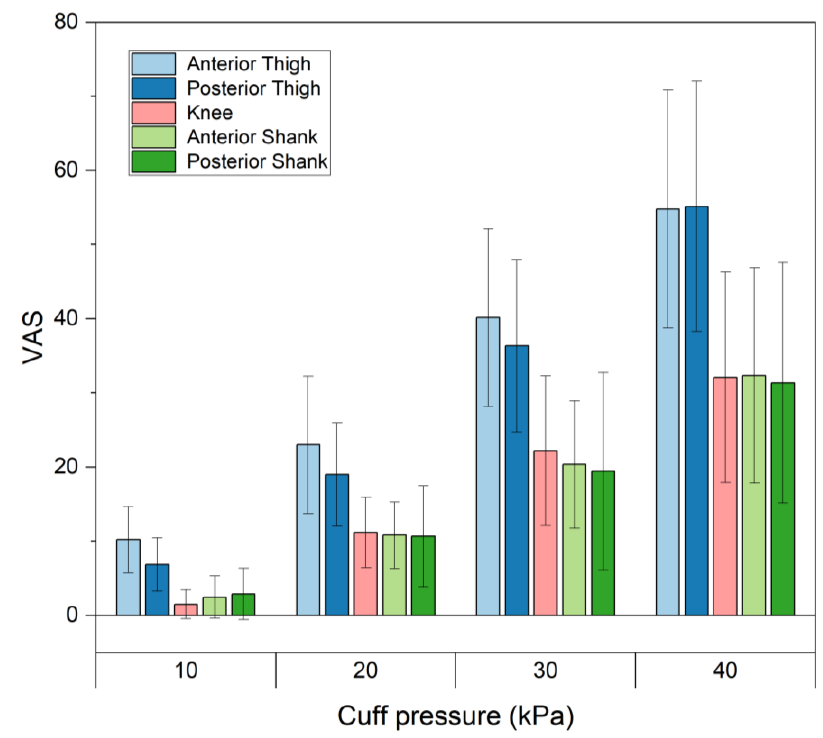
Figure 2. Pain scales for different cuff pressures at various binding